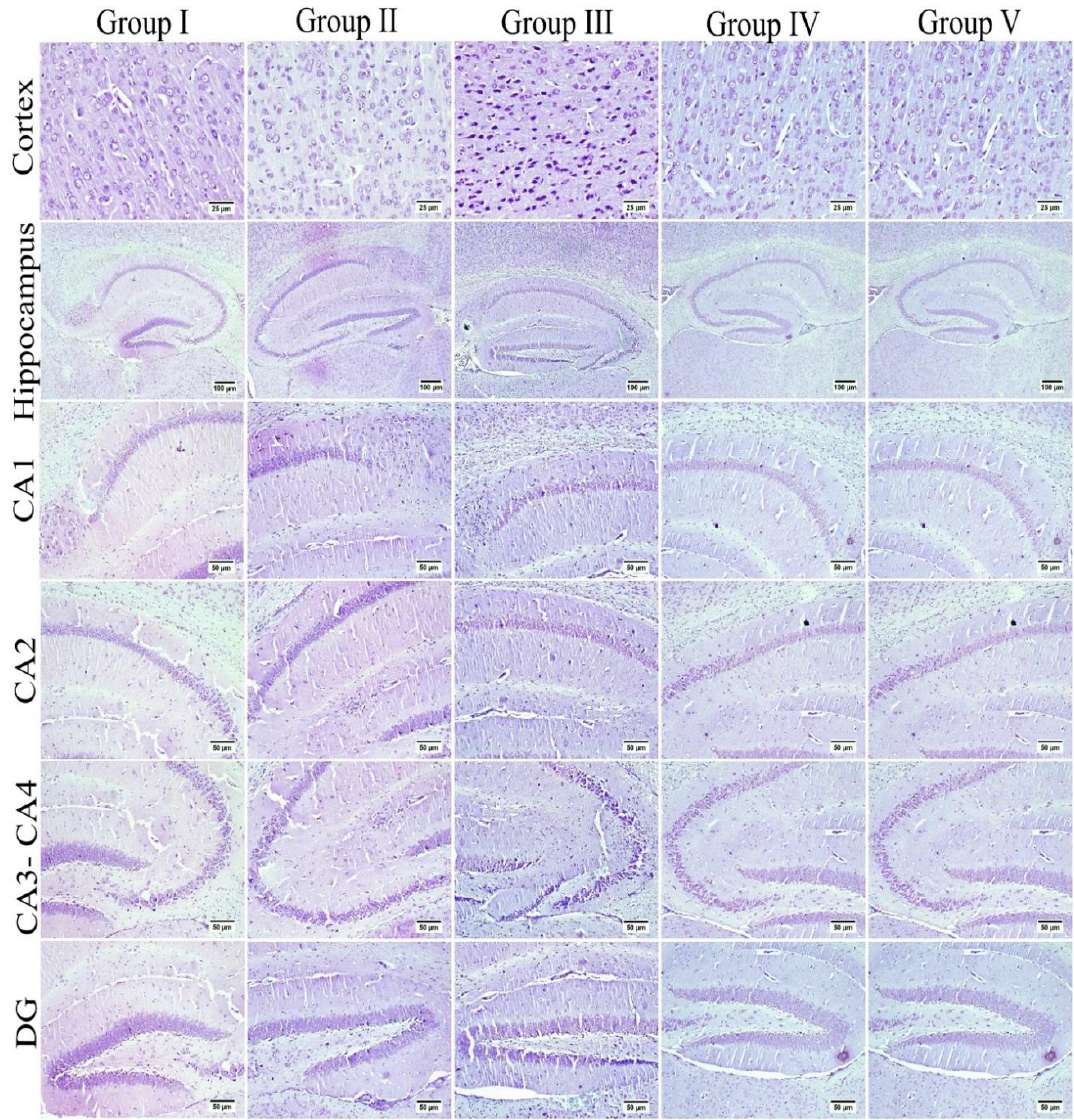
Figure 12. The neuronal survival rate was examined in different experimental groups using Nissl stain. The survival rate was inspected in the cerebral cortex and the hippocampal regions (CA3, CA4, and DG), which showed variation among different groups. Normal control mice and those which received umuhengerin (group I and II) showed normal intact neurons in all brain regions. An increased number of dark and shrunken neurons with pyknotic nuclei was detected in group III, which was injected with STZ. Marked preservation of neurons was observed in the treated groups whether receiving umuhengerin (group IV) or donepezil (group V).